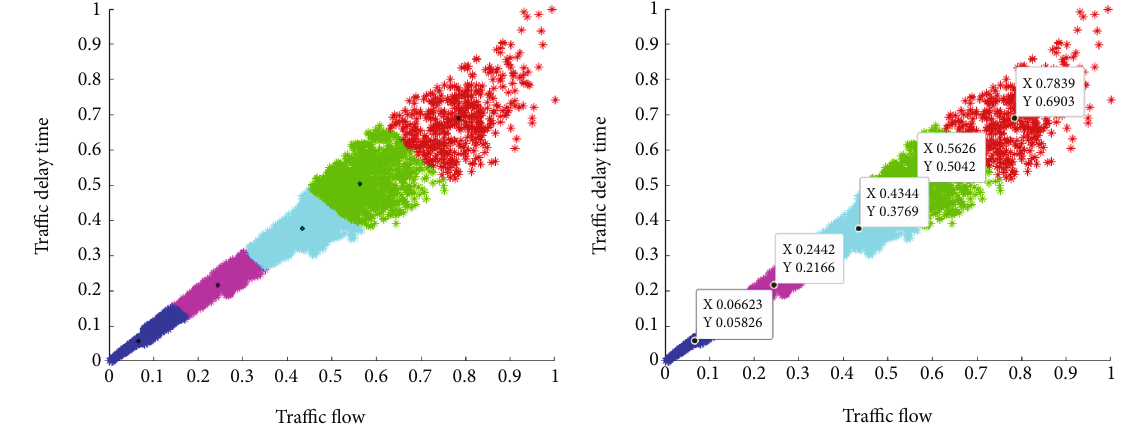
Figure 14: Improved congestion evaluation FCM algorithm clustering